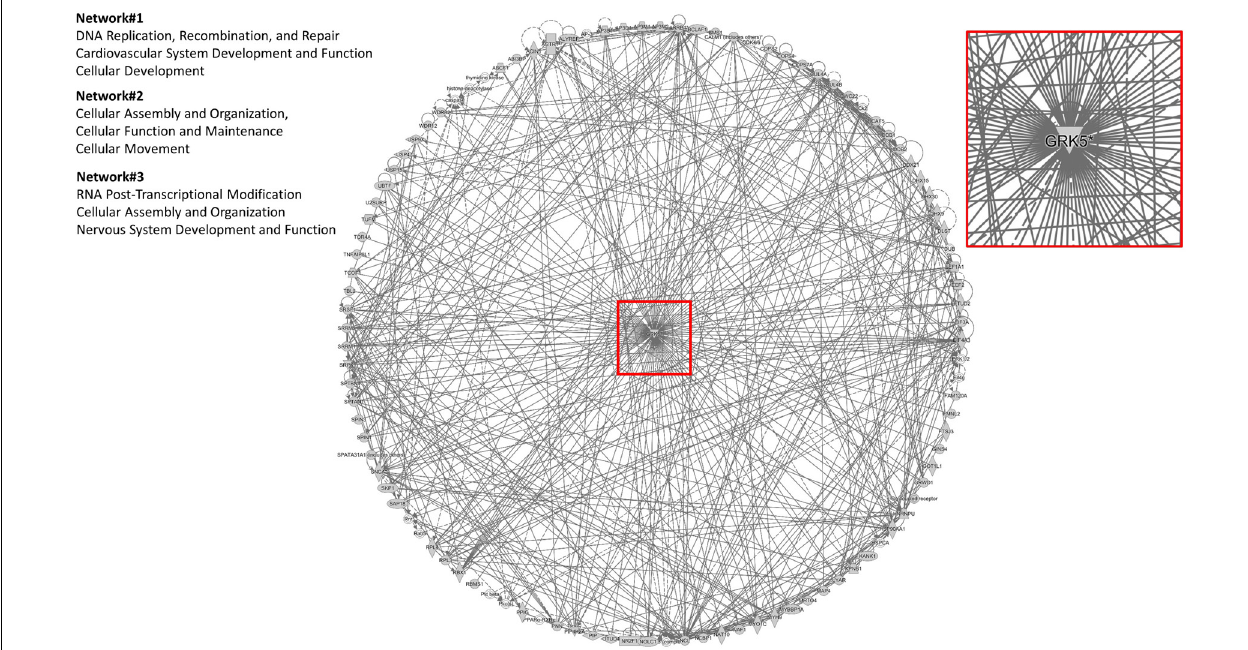
FIGURE 3 | IPA-mediated creation of a radial hierarchical super-network. A radial hierarchical “supernetwork” was constructed using the IPA network construction suite. Through this analysis the three highest scoring networks (based on numbers of interacting proteins from the primary input list of 183 GRK5 interactors) were associated with “ Cellular organization and movement ,” “ Cardiovascular System Development and Function ,” and “ Nervous System Development and Function .” These networks carry physiologically relevant functions germane to the central hypothesis of this review: GRK5 as a functional bridge between cardiovascular and neurodegenerative disorders. Upon merging these top three scoring protein networks we discovered that they all centrally converged upon GRK5